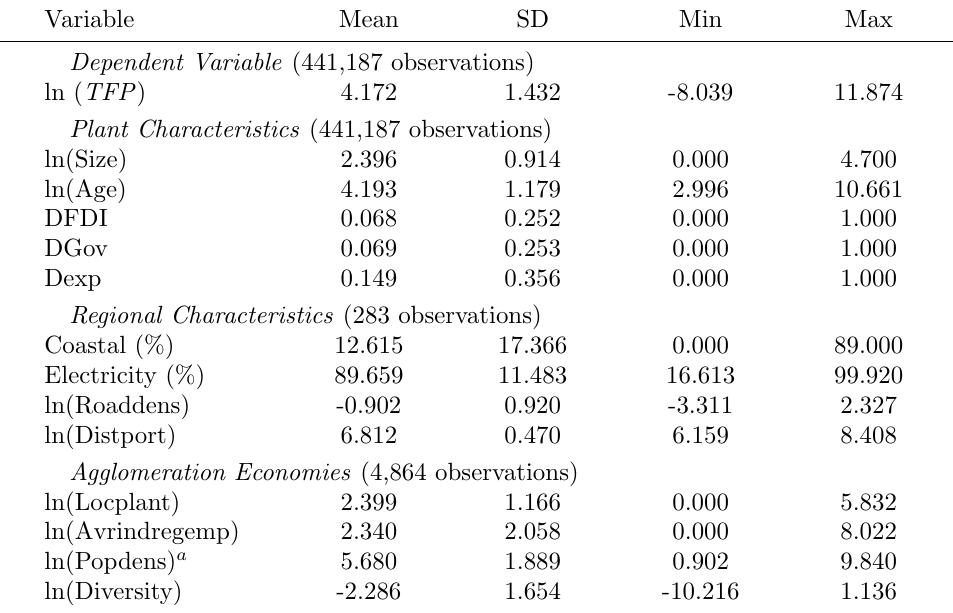
Table 1: Descriptive Statistics of